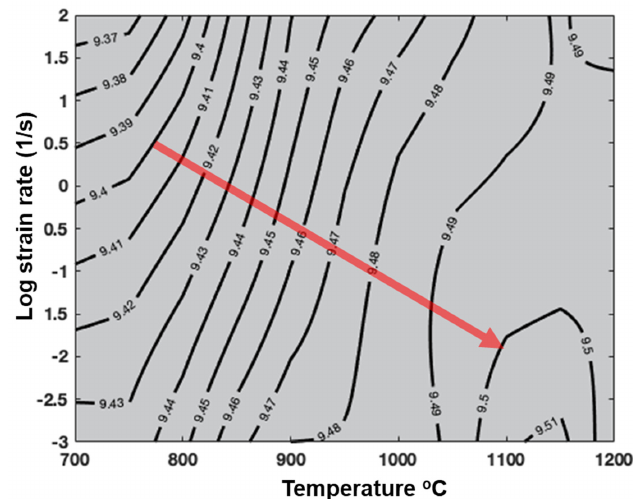
Figure 14. Process maps for TRIP steel composite with 10% zirconia constructed using the results of simulations. The trend of iso ‐ lines shown by red arrow is comparable with the experimental trend published earlier by Guk et al. [31].